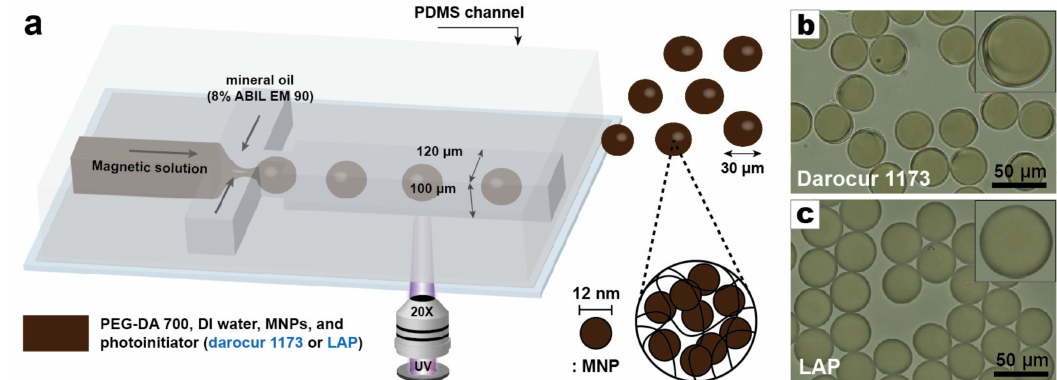
Figure 1. Droplet microfluidics for synthesis of magnetic hydrogels and e ff ect of photoinitiator absorbance on morphology of magnetic hydrogel. ( a ) Droplet generation and particle synthesis in a droplet microfluidic device. Magnetic hydrogels synthesized using: ( b ) Darocur 1173, or ( c ) lithium phenyl (2,4,6–trimethylbenzoyl) phosphinate (LAP) dispersed in DI